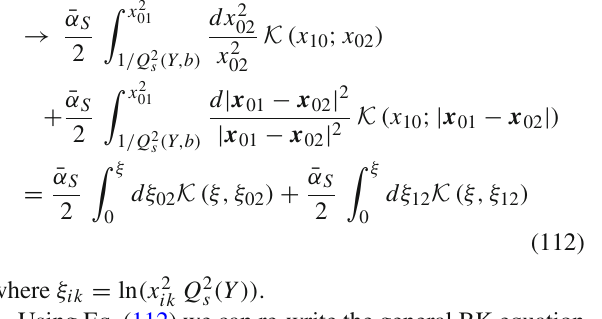
Fig. 8 Comparisons solutions to Eqs. (98b) and to (118)